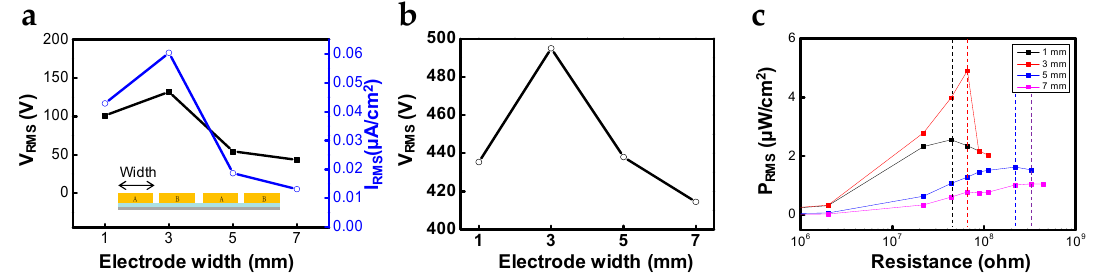
Figure 2. Output performance evaluation and simulation versus electrode width: ( a ) output voltage and short-circuit current; ( b ) COMSOL simulation result (open-circuit voltage) with a resistance of 100 G Ω for open-circuit condition; ( c ) output power in root mean square (RMS) value and different optimum resistance according to changes in the electrode width.